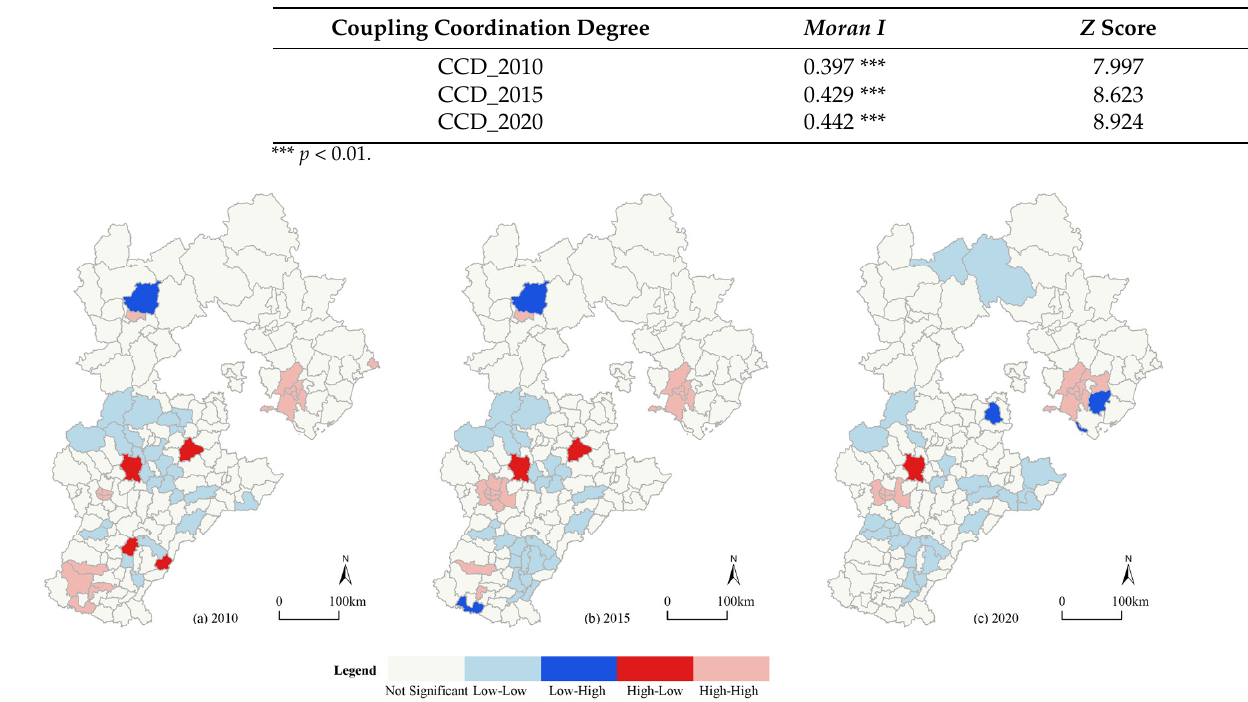
Figure 8. Spatial distribution of the coupling coordination degree of 167 counties in Hebei. ( a ) Spatial distribution in 2010; ( b ) spatial distribution in 2015; ( c ) spatial distribution in 2020.